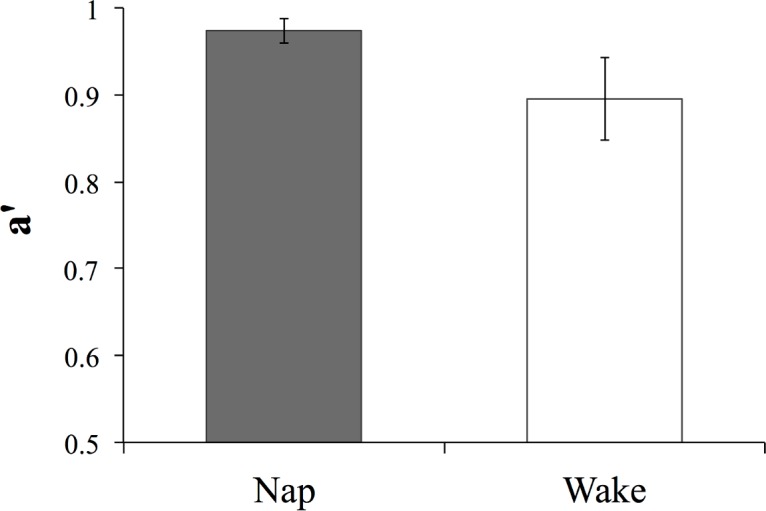
Performance on the auditory translation recognition task for the two groups.Error bars represent 95% CIs.